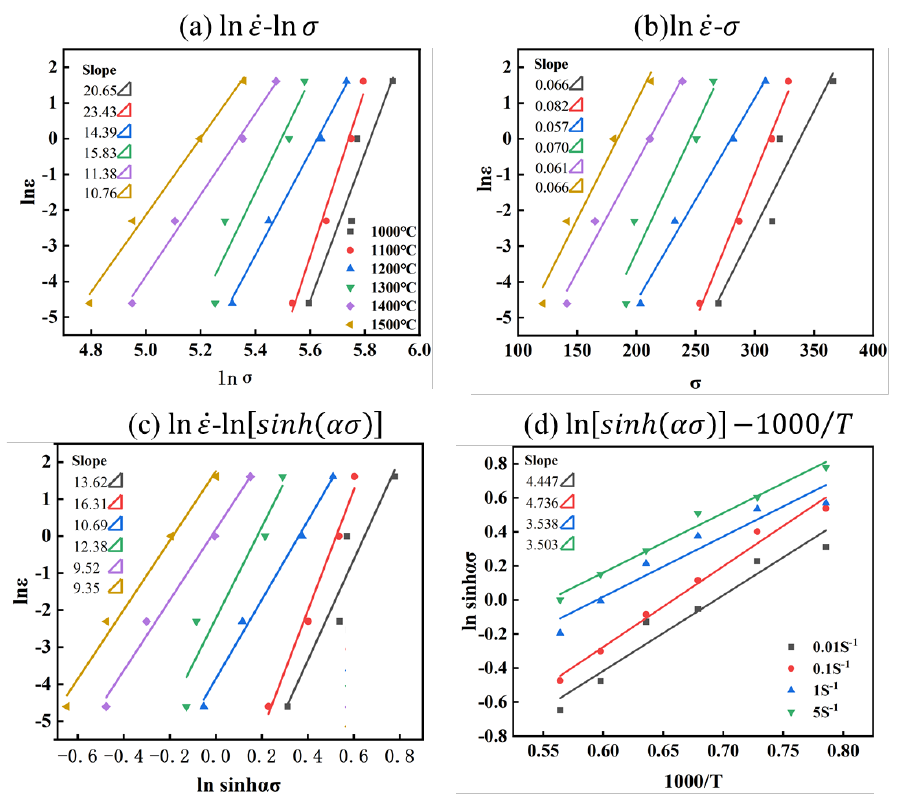
. . ε − ln σ , ( b ) ln ε − σ ,